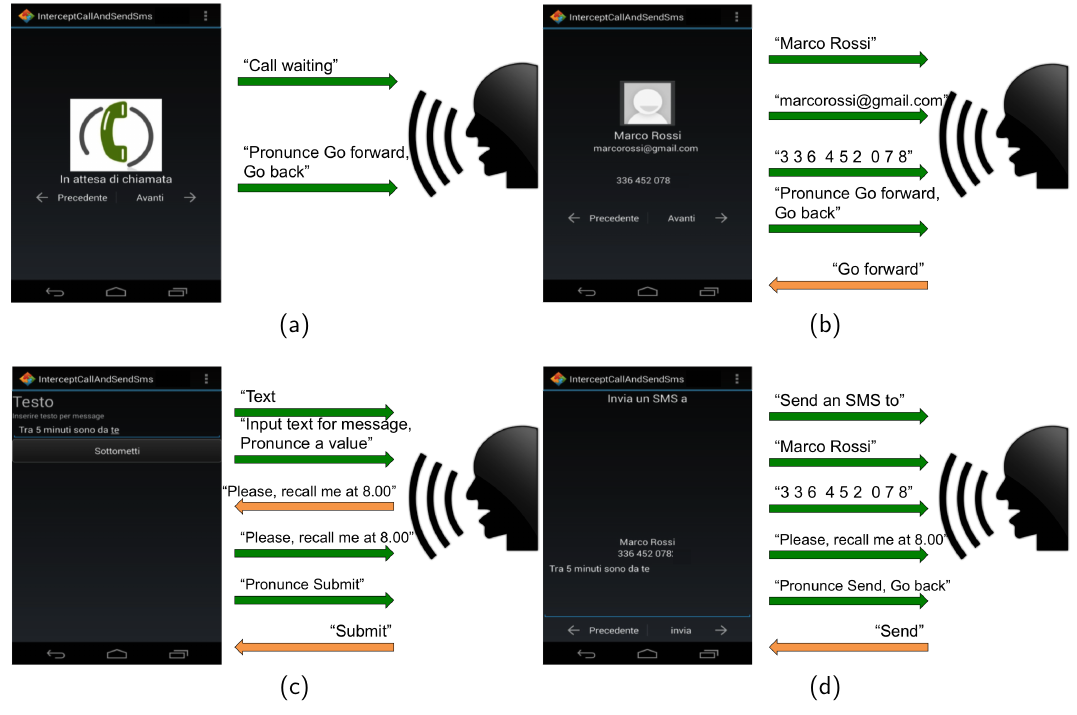
Figure 11. User interaction with the Phone.InterceptorCall ( a ); Contact.Preview ( b ); Text.Text ( c ); and Text.SMS ( d )